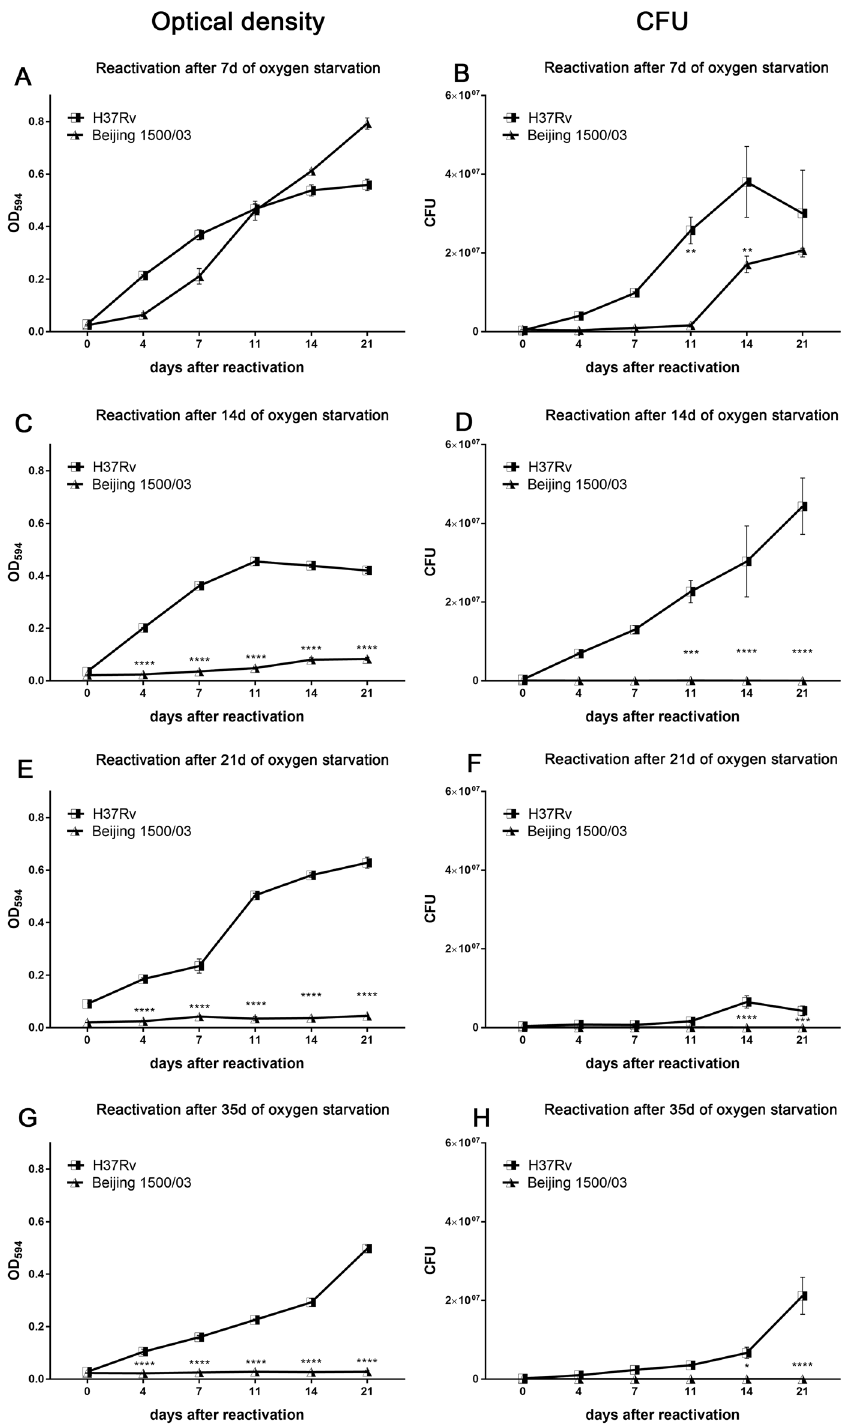
Figure 5. Beijing (L2) reactivated only after a short, but not after prolonged periods of O 2 starvation. After O 2 starvation for indicated time periods, cultures were inoculated (1:10) in fresh medium at indicated time points and growth recovery was followed by OD 594 ( A , C , E , G ) or CFU ( B , D , F , H ). Beijing (L2) 1500/03 did not recover from O 2 starvation for 14, 21 and 35 days, but did recover from O 2 starvation for 7 days. In contrast, H37Rv (L4) reactivated after all O 2 starvation periods. n = 1 independent experiments with triplicates in each. *p < 0.05, **p < 0.005, ***p < 0.005, ****p < 0.0001, two-way